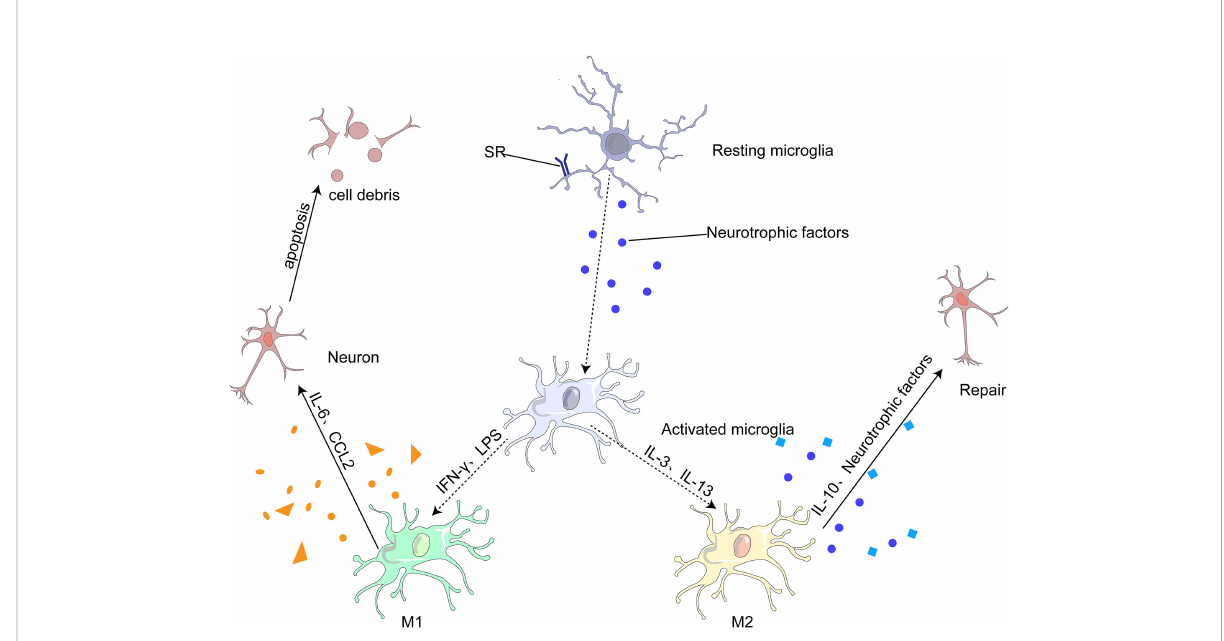
FIGURE 3 Most microglia can be divided into two opposite types: classical (M1) or alternative (M2). M1 microglia release in fl ammatory mediators, such as IL-6 and CCL2, which induce in fl ammation and neurotoxicity. M2 microglia release anti-in fl ammatory mediators, such as IL-10 and neurotrophic factor, which induce anti-in fl ammatory and neuroprotective